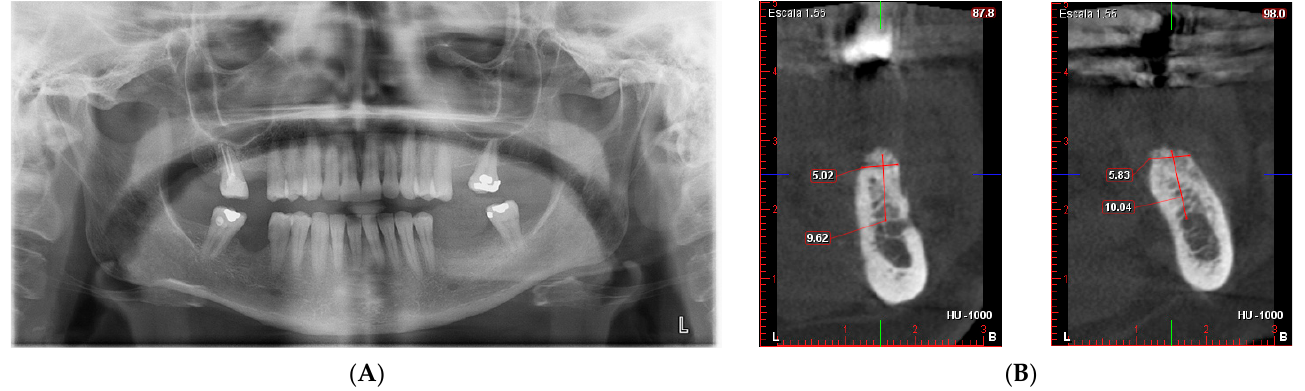
Figure 10. ( A ) Orthopantomography after mesh removal. ( B ) CBCT with measurements for implant placement.